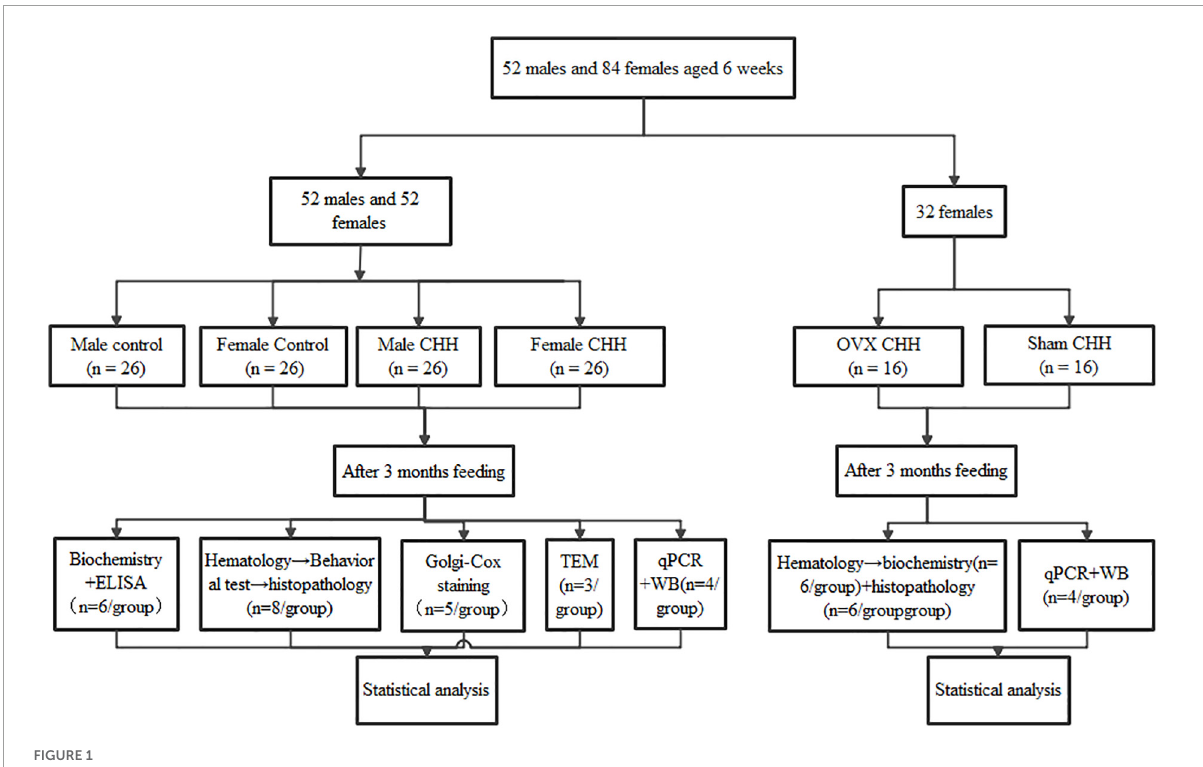
FIGURE1 Flow chart of the